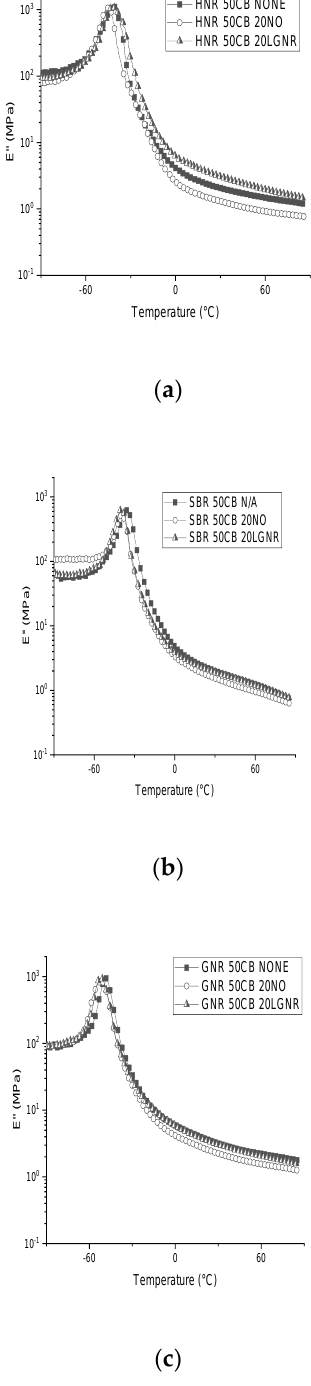
Figure 10. Loss modulus (E ’’) of rubber composites made with or without processing aids from − 90 °C to 90 °C: ( a ) Hevea natural rubber (HNR); ( b ) styrene butadiene rubber (SBR); ( c ) guayule natural rubber (GNR). N/A: rubber compounds without processing aids; 20 NO: rubber compounds with 20 phr naphthenic oil; 20 LGNR: rubber compounds with 20 phr liquid guayule natural rubber.